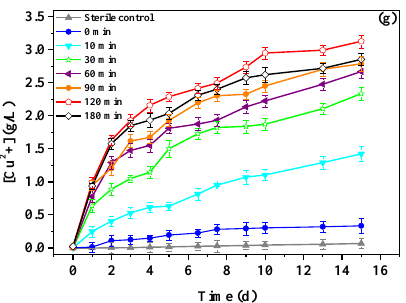
Figure 5. The changes in redox potential values ( a ), pH values ( b ), cell densities ( c ), cell adsorption ( d ), [Fe 3 + ] ( e ), total [Fe] ( f ) and [Cu 2 + ] ( g ) during the bioleaching of chalcopyrite mechanically activated in different time. Error bars represent standard deviation from three independent experiments (n = 3).